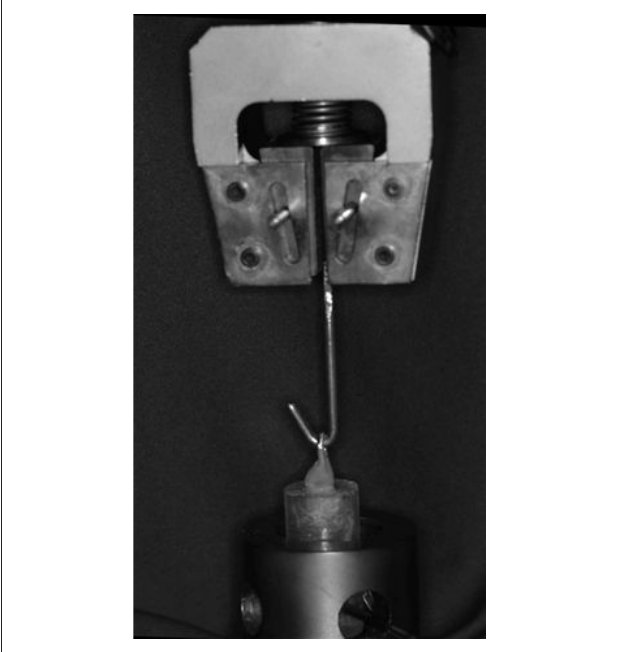
Fig. 2. Specimens subjected to tensile load at 180 o in a universal testing